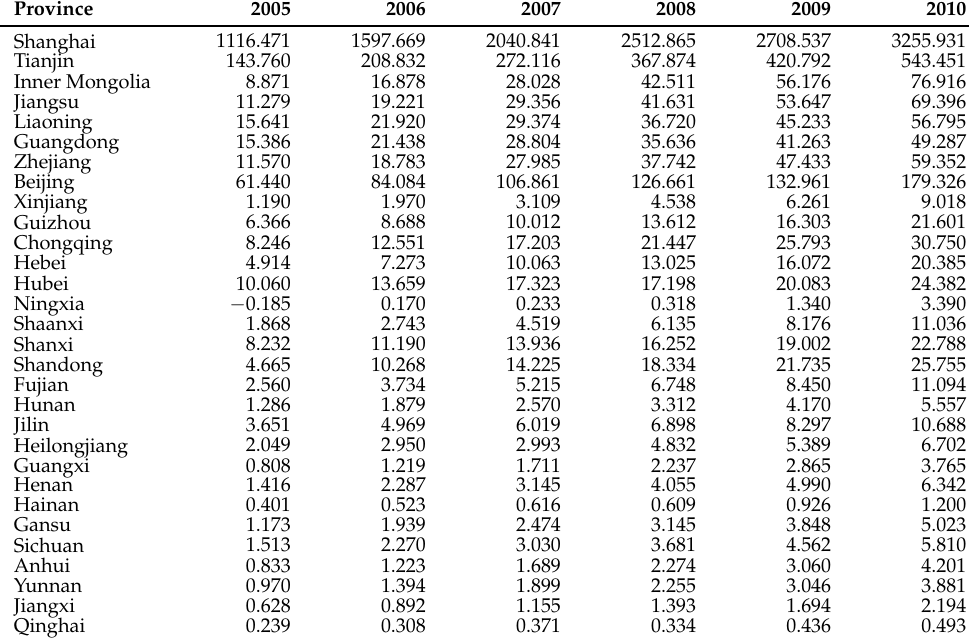
Table A5. The intra-provincial carbon inequality estimation results of original carbon emission data based on a 3-year rolling window for 30 provinces in China from 2005 to 2010.